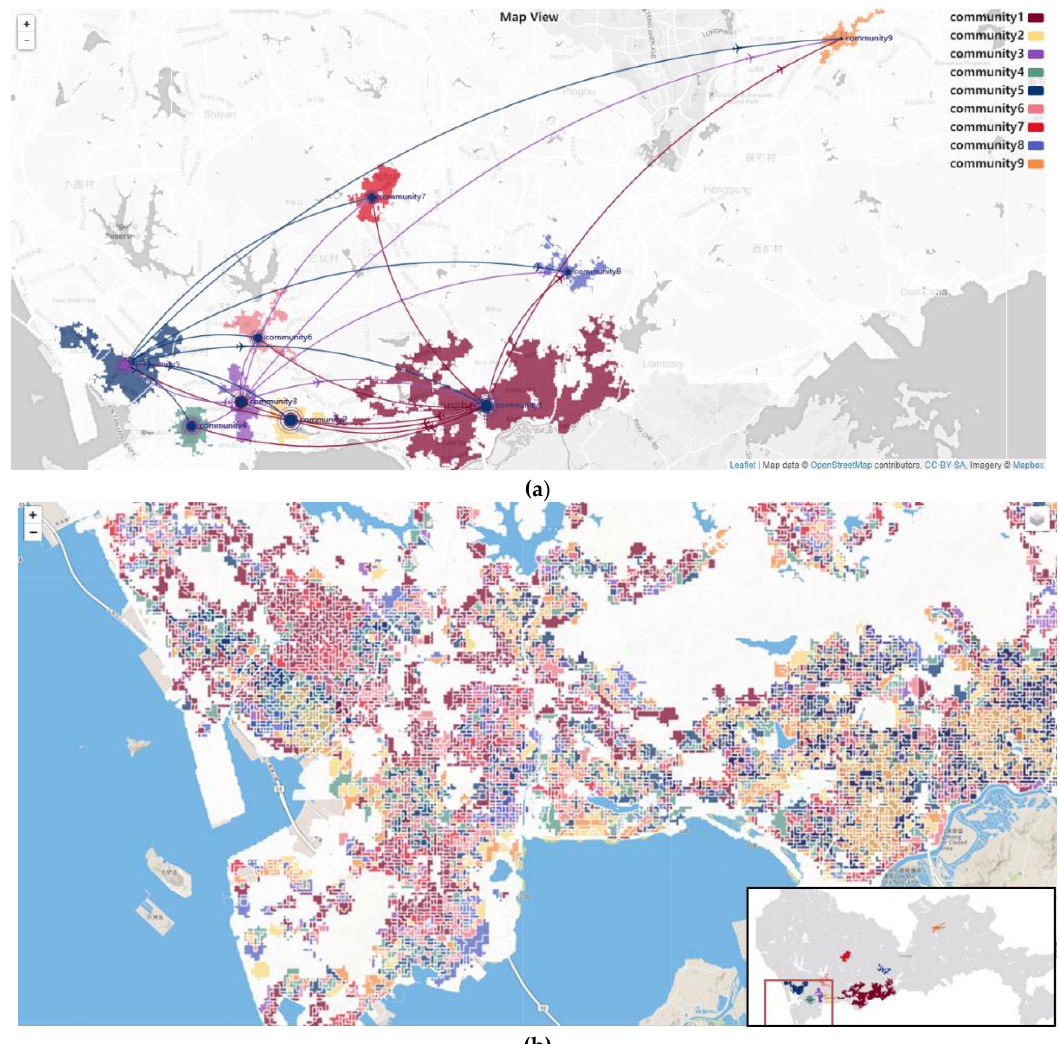
Figure 3. Transit-based mobility community structure on a holiday. ( a ) High-level community flow map; (b) low-level community clusters.